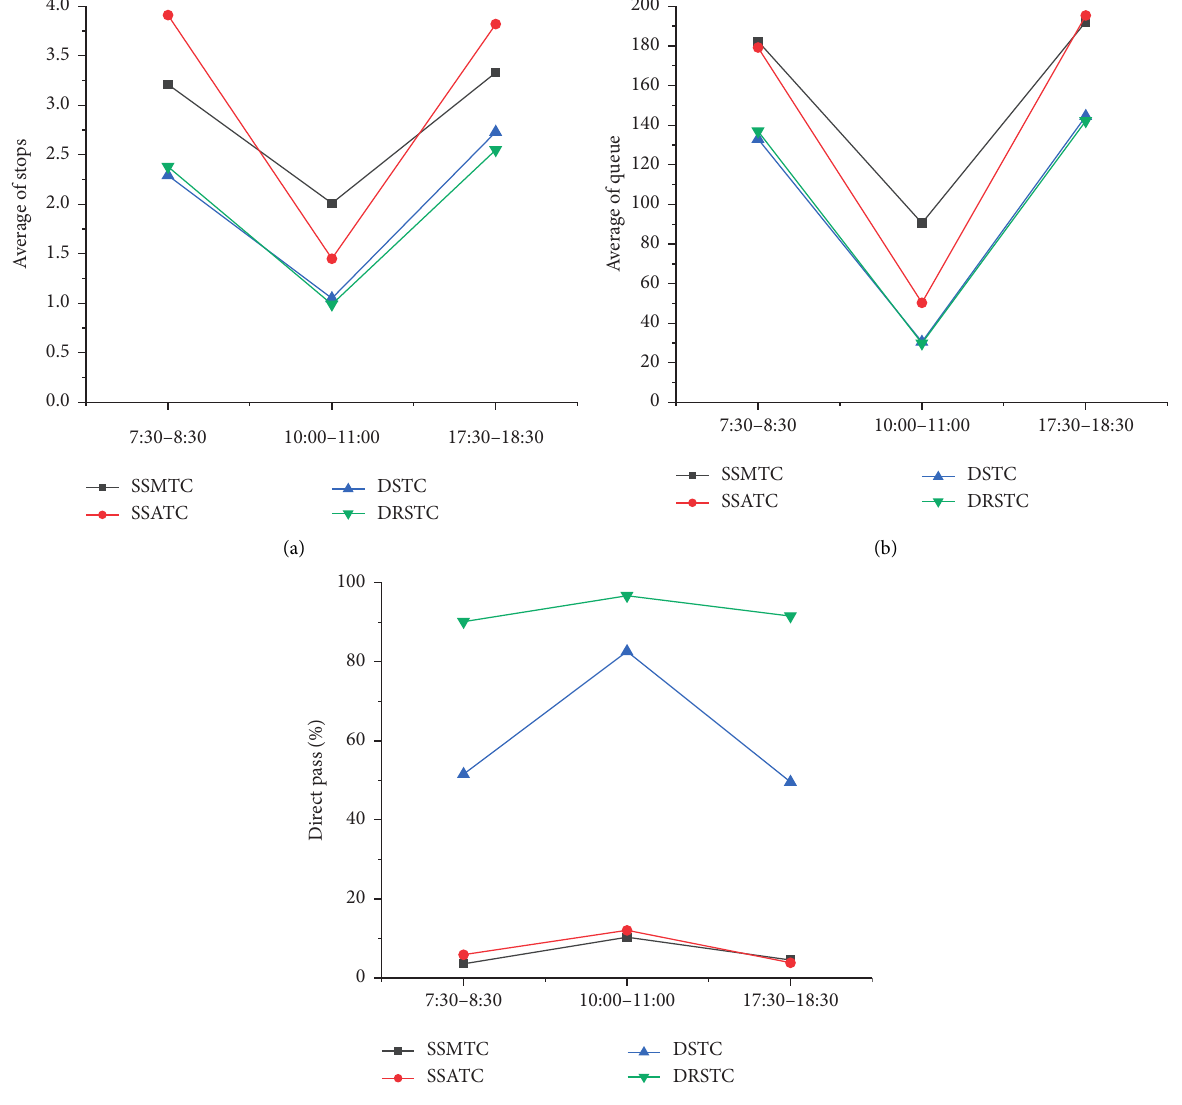
Figure 15: Comparison of evaluation indicators of four control methods. (a) Comparison of average of stops. (b) Comparison of average of queue. (c) Comparison of direct pass rate.